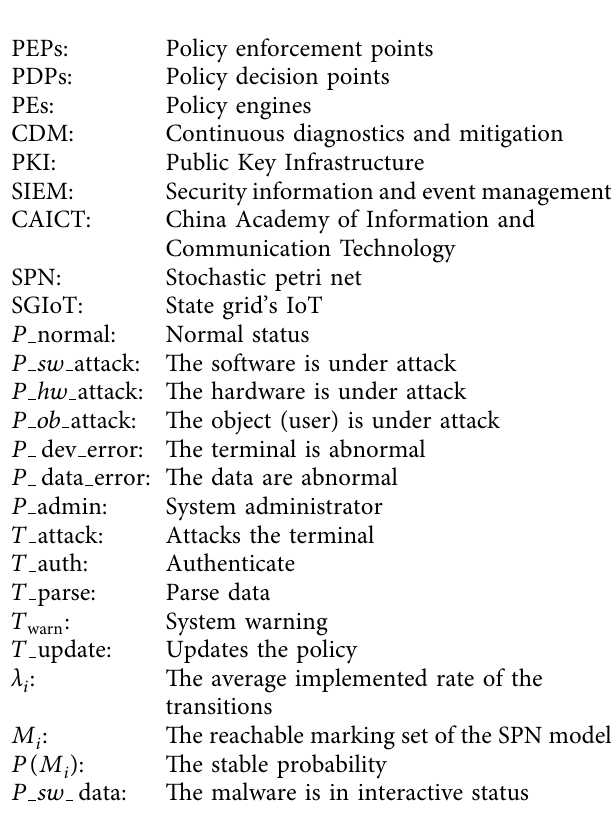
Figure 12: Network security situation analysis of the attacked terminal.